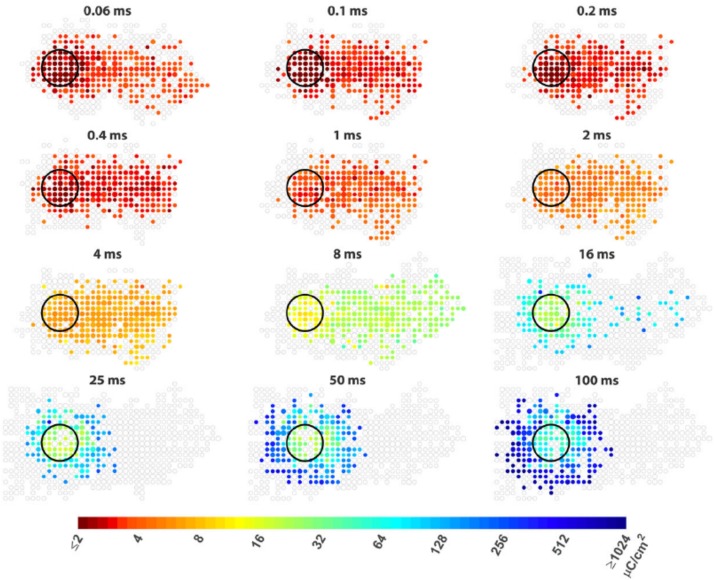
Improving the spatial resolution of electrical stimulation. The spatial threshold maps of RGC responses to epi-retinal stimulation with different pulse durations. The stimulating electrode is shown as black circles. Each colored dot represents the average threshold charge density needed to stimulate cells at its location. The area containing cells that did not response to stimulation are shown as unfilled gray dots. The dot sizes indicate the number of cells. Axon run from right (somas) to left (optic disc). The colored dots at right indicate somas of the cells whose passing axons are activated by the electrode. Figure adapted with permission from Weitz et al. (2015).